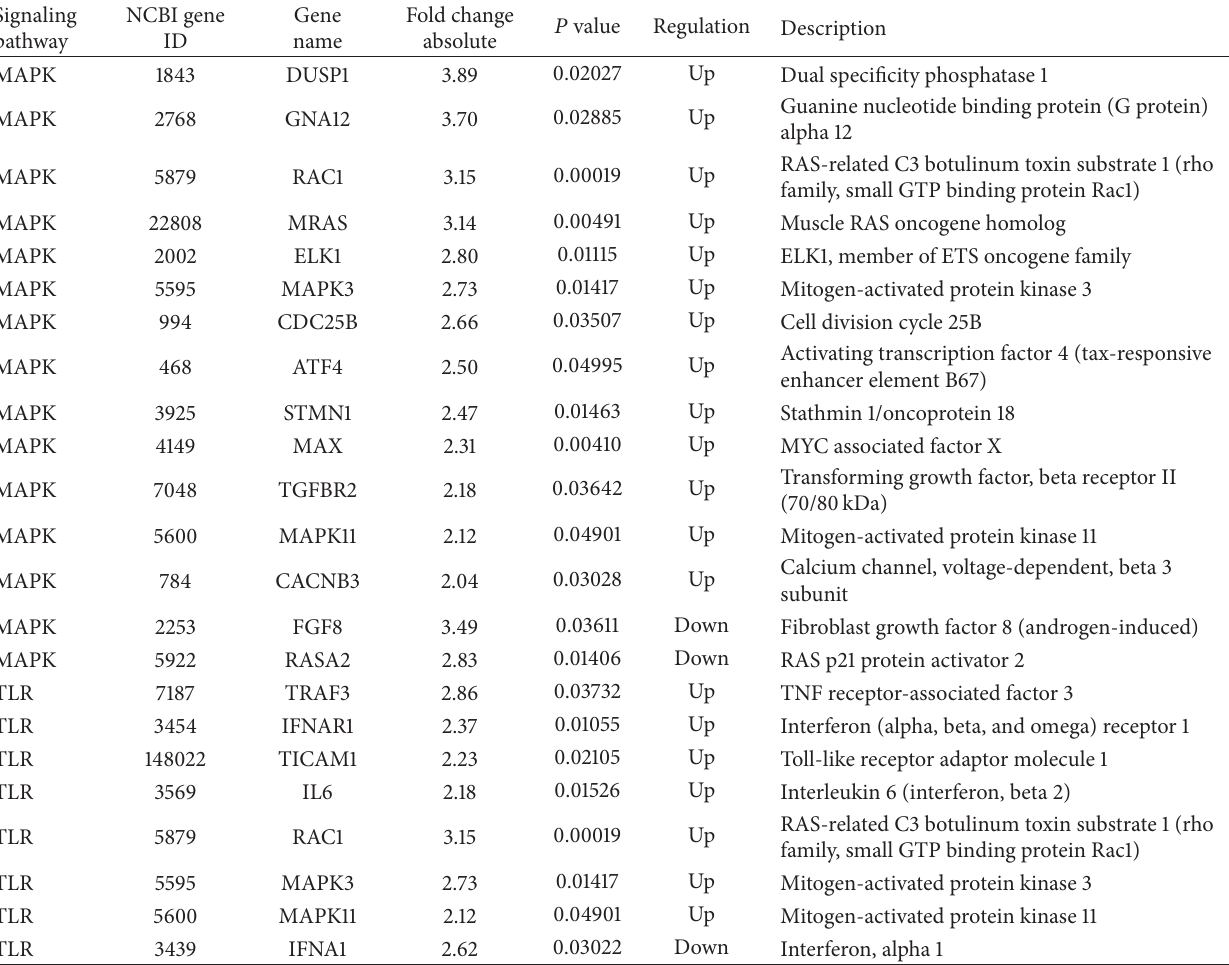
Table 5: Key gene list of signaling pathways related to